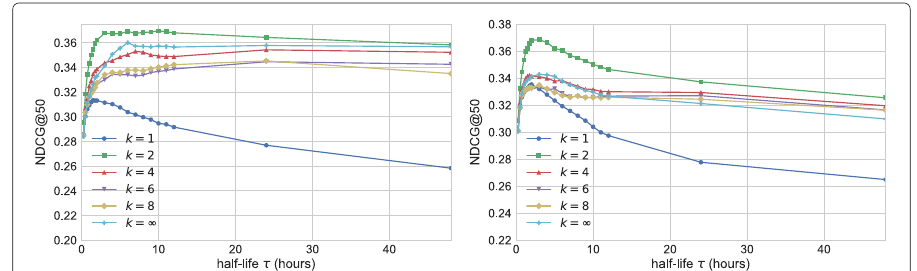
Fig. 12 NDCG@50 performance of temporal Katz centrality as the function of half-life parameter τ . Different curves correspond to the different values of k . We set β = 1. Left: UO17, Right: RG17